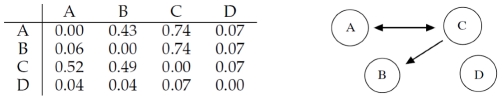
Left: mean correlation values inferred with RegnANN.Right: inferred interaction among the genes for correlation greater than .